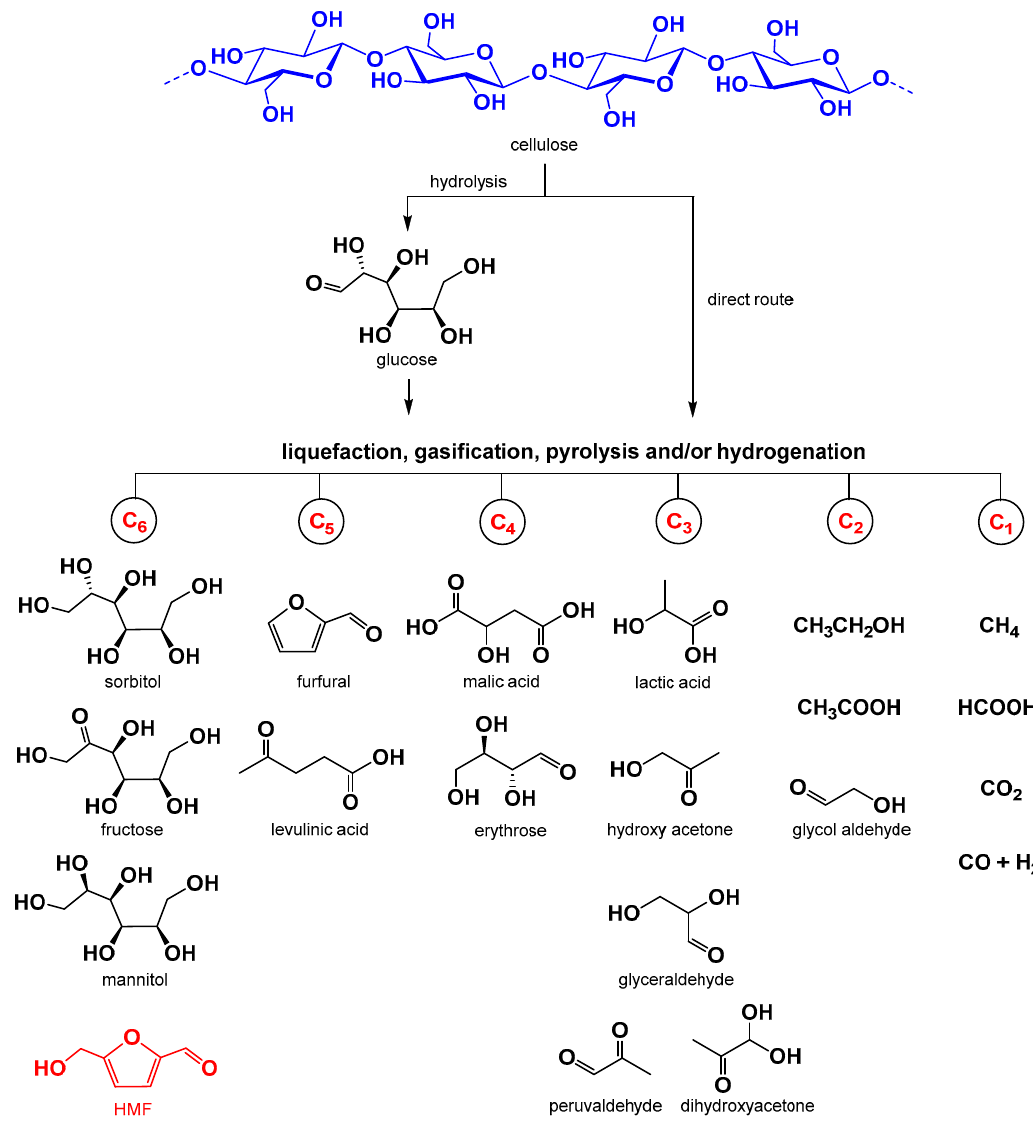
Figure 3. Pathway to HMF from cellulose.